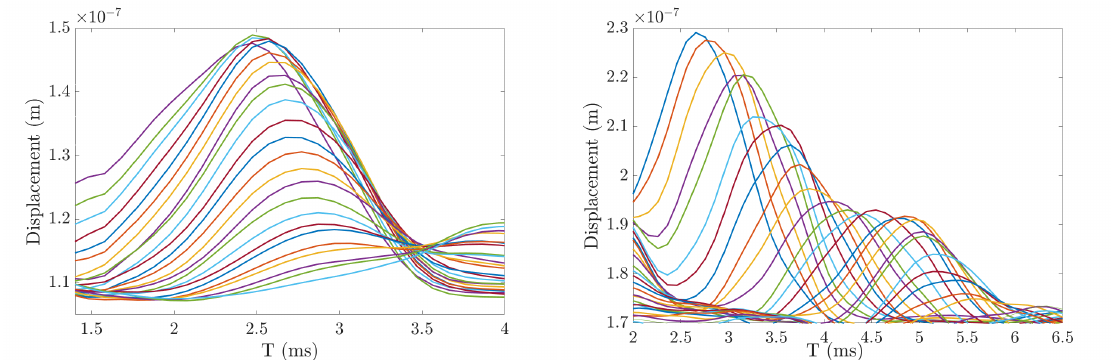
Figure 10. Experimental particle displacement versus time profiles at the focal depth resulting from the ARFI excitation. The ARFI moves the tissue in the axial and lateral position. In this figure, each displacement trace indicates a lateral position starting nearby the ARFI push focus to 24 lateral positions. Each individual color curve indicates the lateral position of a displacement trace for ex vivo liver sample II ( left ) and hydrogel phantom II ( right ). The curves show that, at farther distances (few milliseconds after the push), the particle displacement is reduced, since the shear wave dissipates.